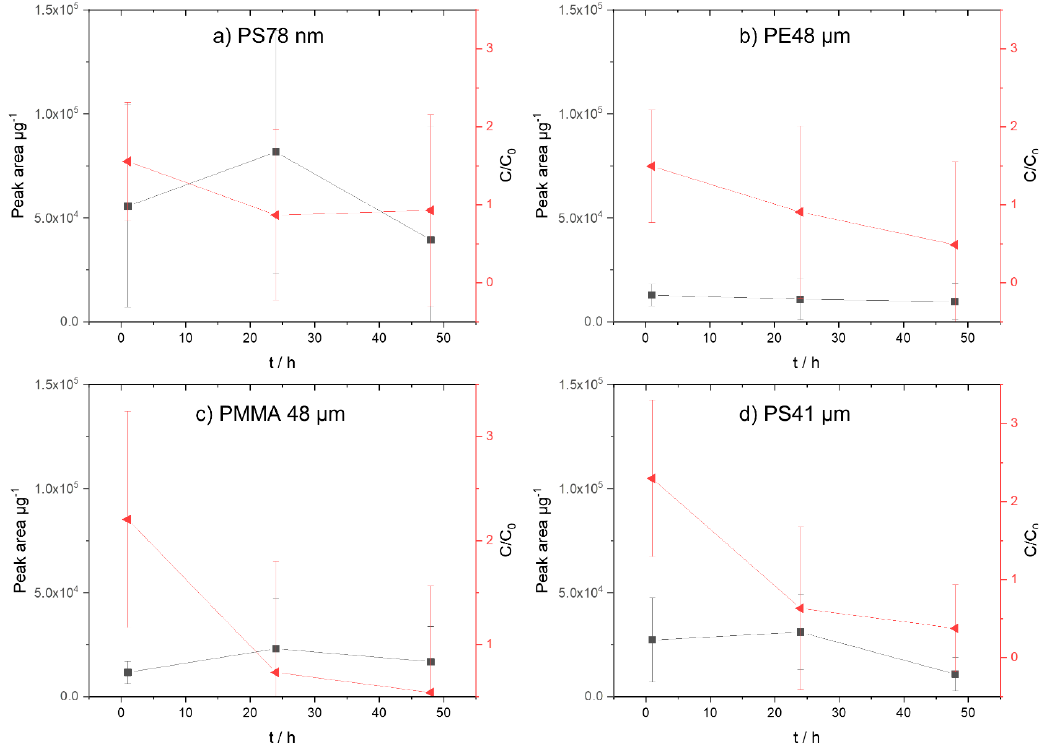
Figure 4. Concentration of α -cypermethrin on micro- and nanoplastic particles. On the left y − axis (black, square), the sorption on the particles (peak area µg − 1 ) is shown; on the right y − axis (red, triangle), the concentration in the aqueous phase (C/C 0 ) is presented. ( a ) PS 78 nm, ( b ) PE 48 µm, ( c ) PMMA 48 µm, and ( d ) PS41 µm.